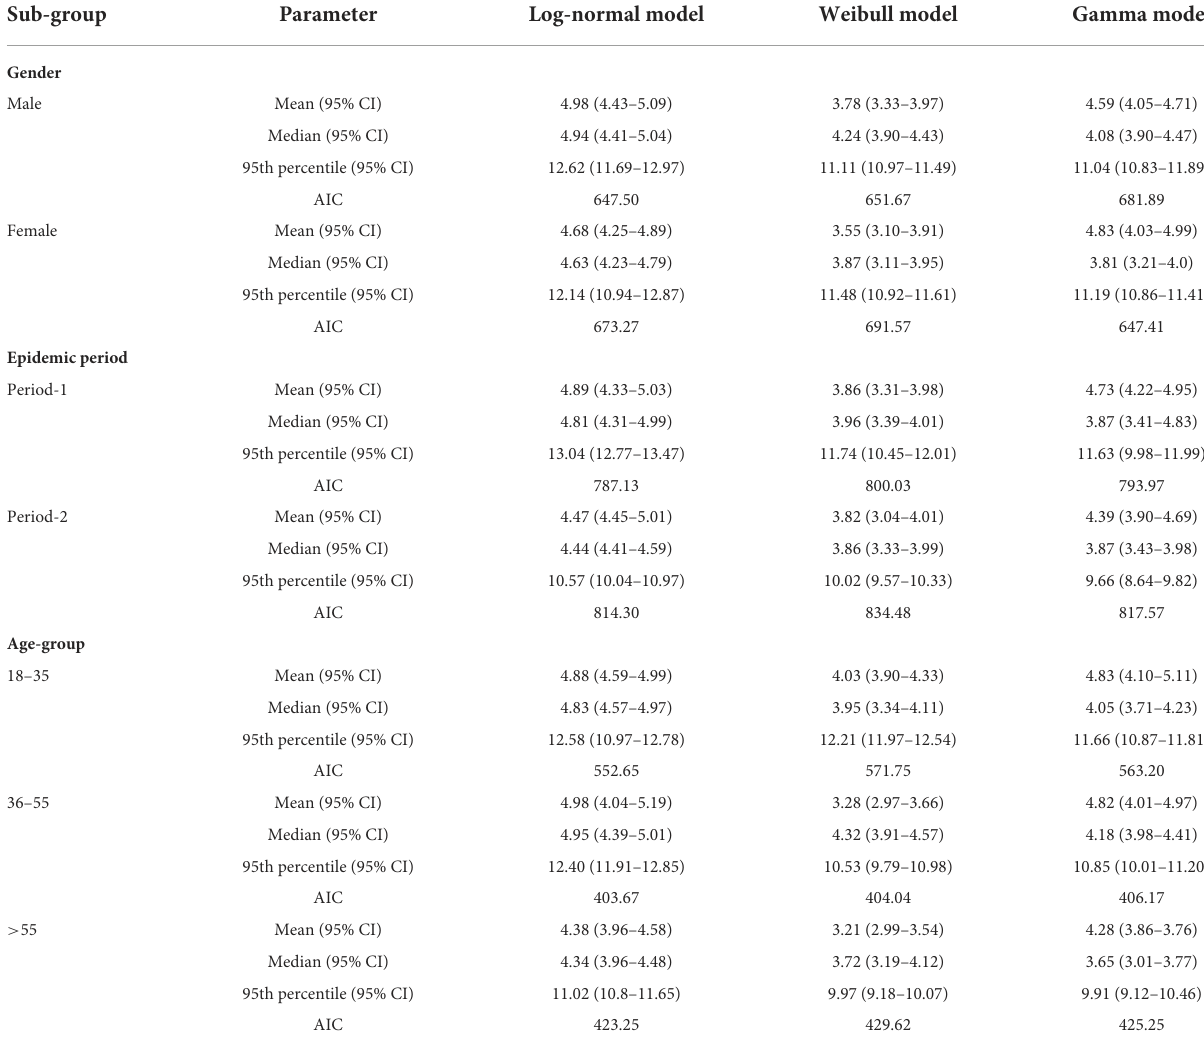
TABLE 3 Estimated incubation period for confirmed COVID-19 cases stratified by gender, epidemic period, and age group